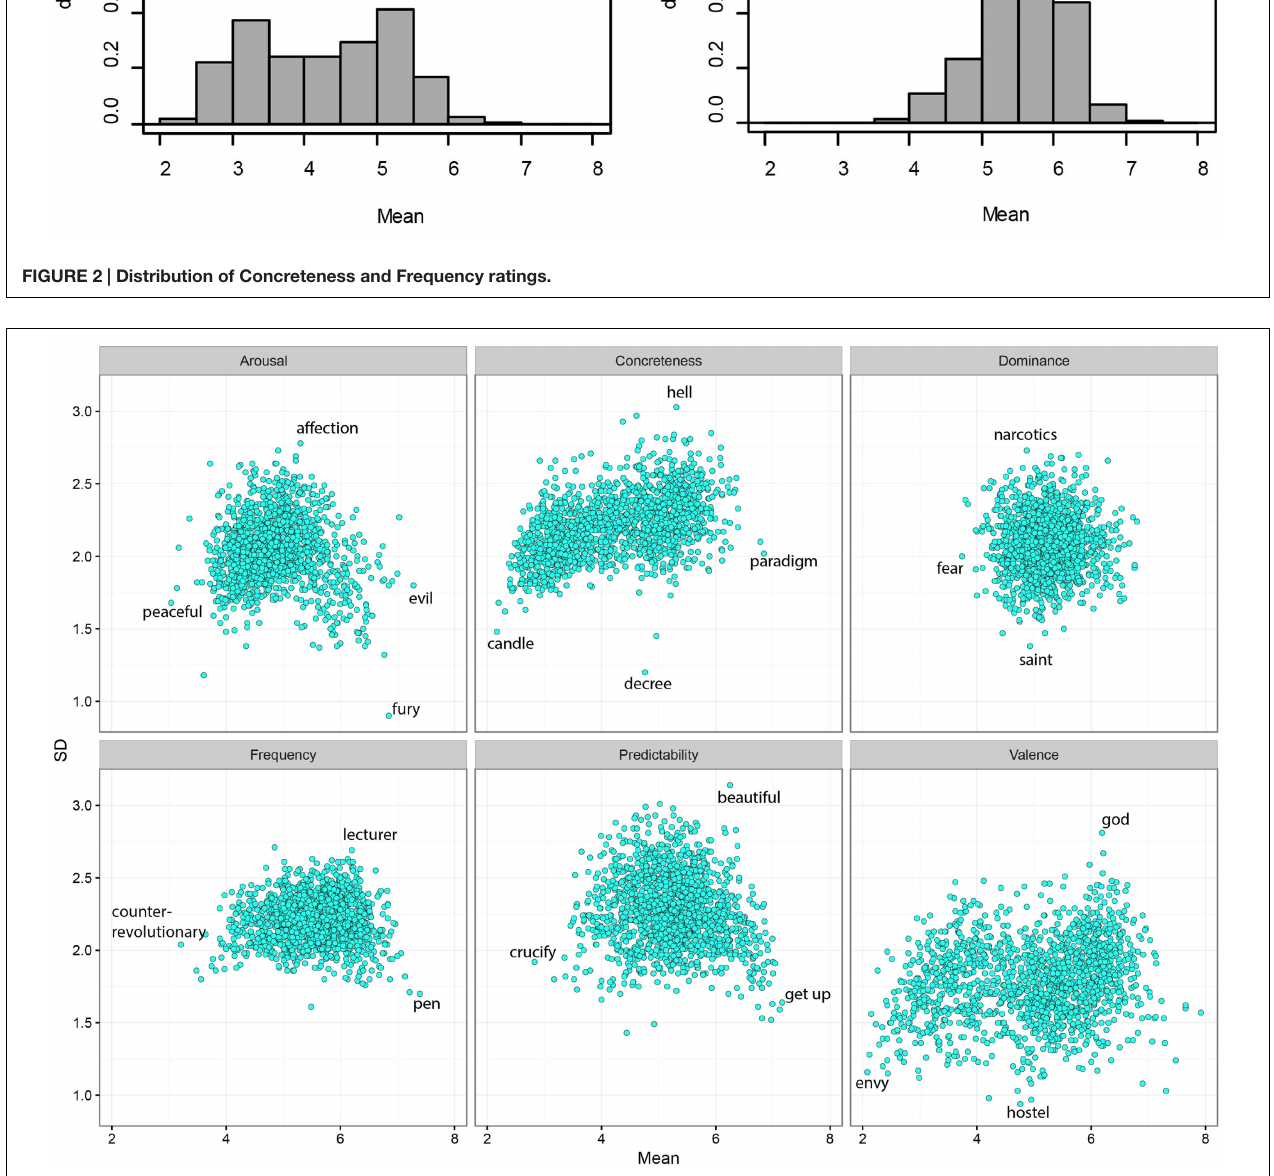
FIGURE 3 | Means of ratings plotted against the SDs for all 1,490 Indonesian